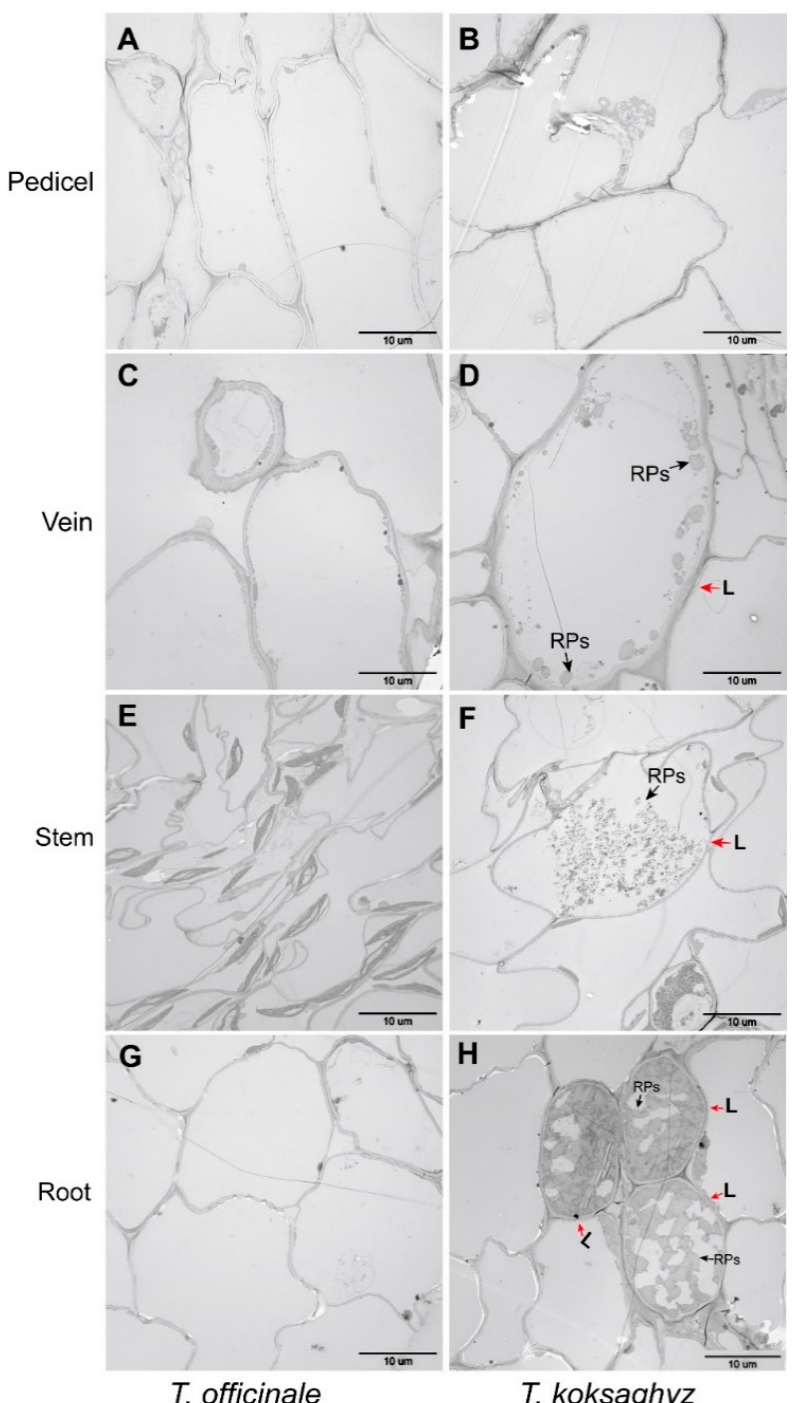
Figure 3. Accumulation patterns of rubber particles and laticifer cells in different tissues of T. officinale and T. kok-saghyz . Typical ultrastructural patterns of rubber particles and laticifers (L) in different TKS tissues were examined under a TEM, which are marked with black and red arrows, respectively. Many spherical and pear-like rubber particles can be detected ( D , F , H ) in TKS (Vein, Stem, Root), but both rubber particles and laticifer cells cannot be found in the pedicel tissue of TKS ( B ) and all the detected tissues in T. officinale under a TEM ( A , C , E , G ).